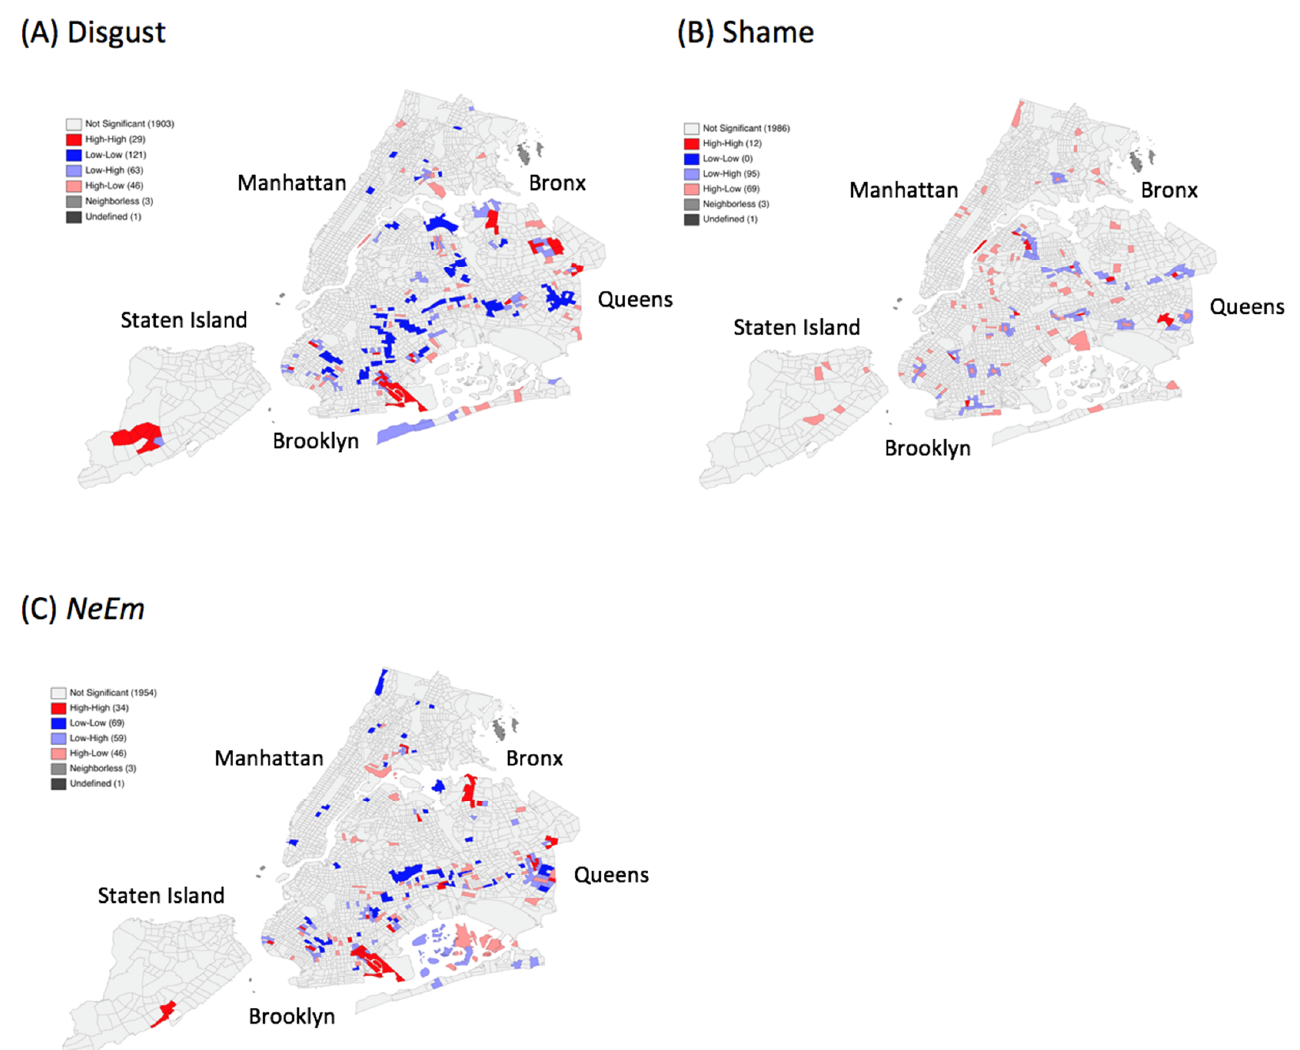
Figure 2. Univariate spatial clusters of ( A ) Disgust, ( B ) Shame, and ( C ) the combined set of negative emotions ( NeEm ) post- disaster.